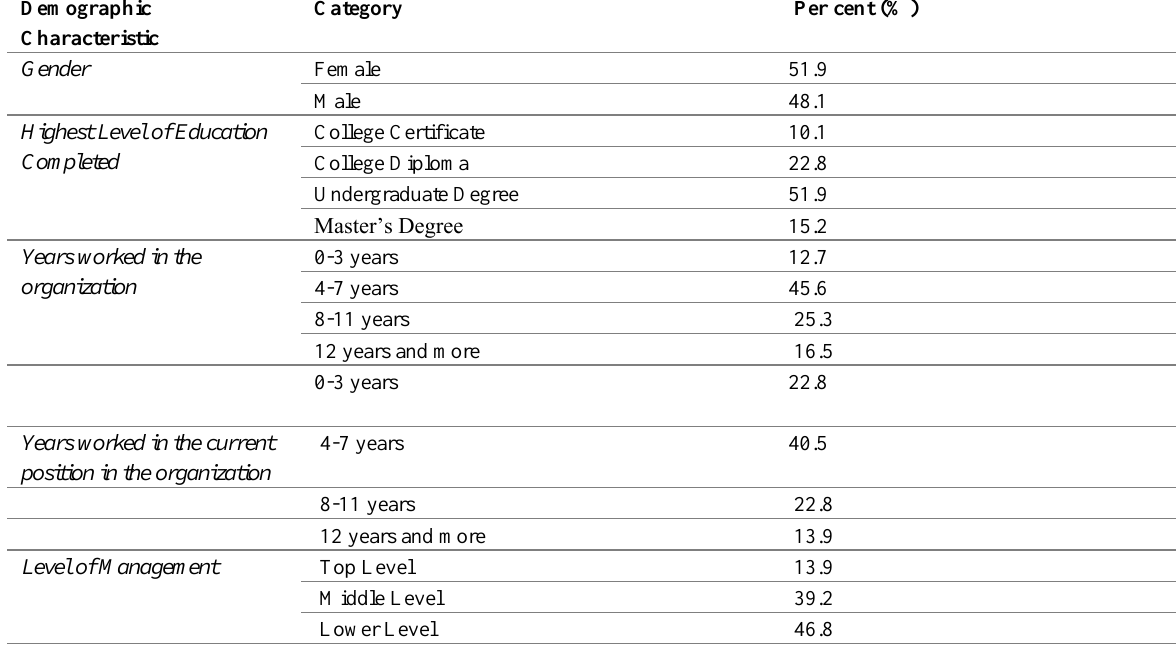
Table 2: Background Information of the